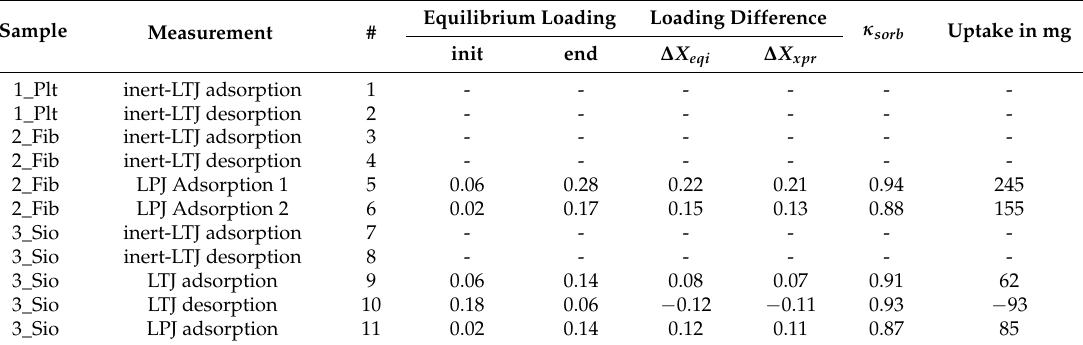
Table 5. Calculated and measured loading difference of all sorption measurements.